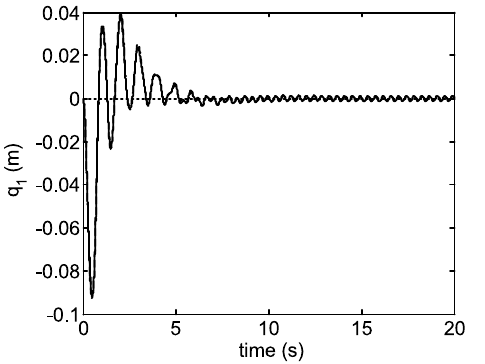
Fig. 8. Estimated (- - -) and “real” (—) behavior of measured vari- able q 1 considering different initial